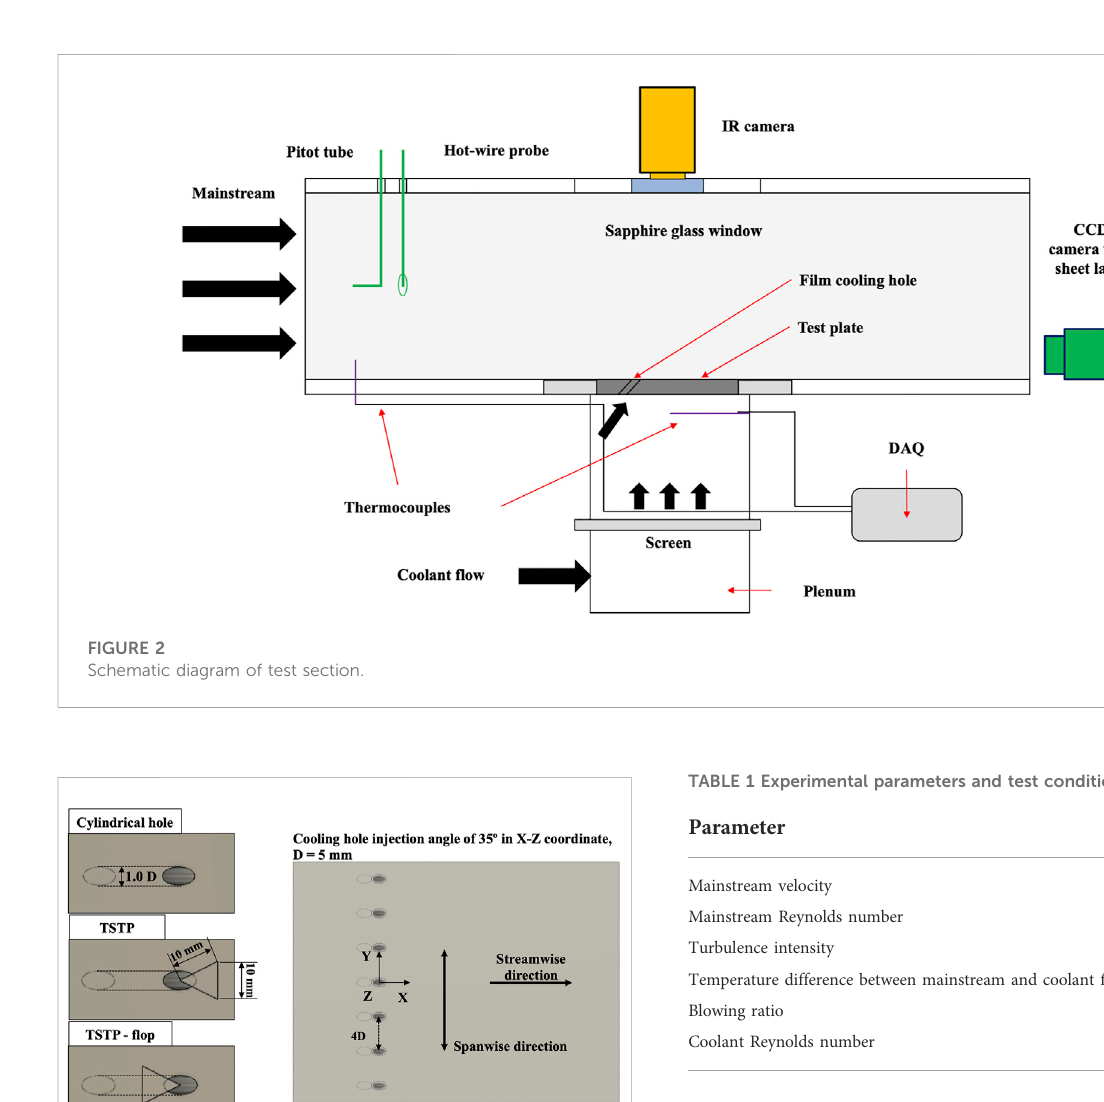
FIGURE 3 Designcon fi gurationforthecylindricalhole,TSTP,andTSTP- fl op. The coordinate and the directions are displayed.